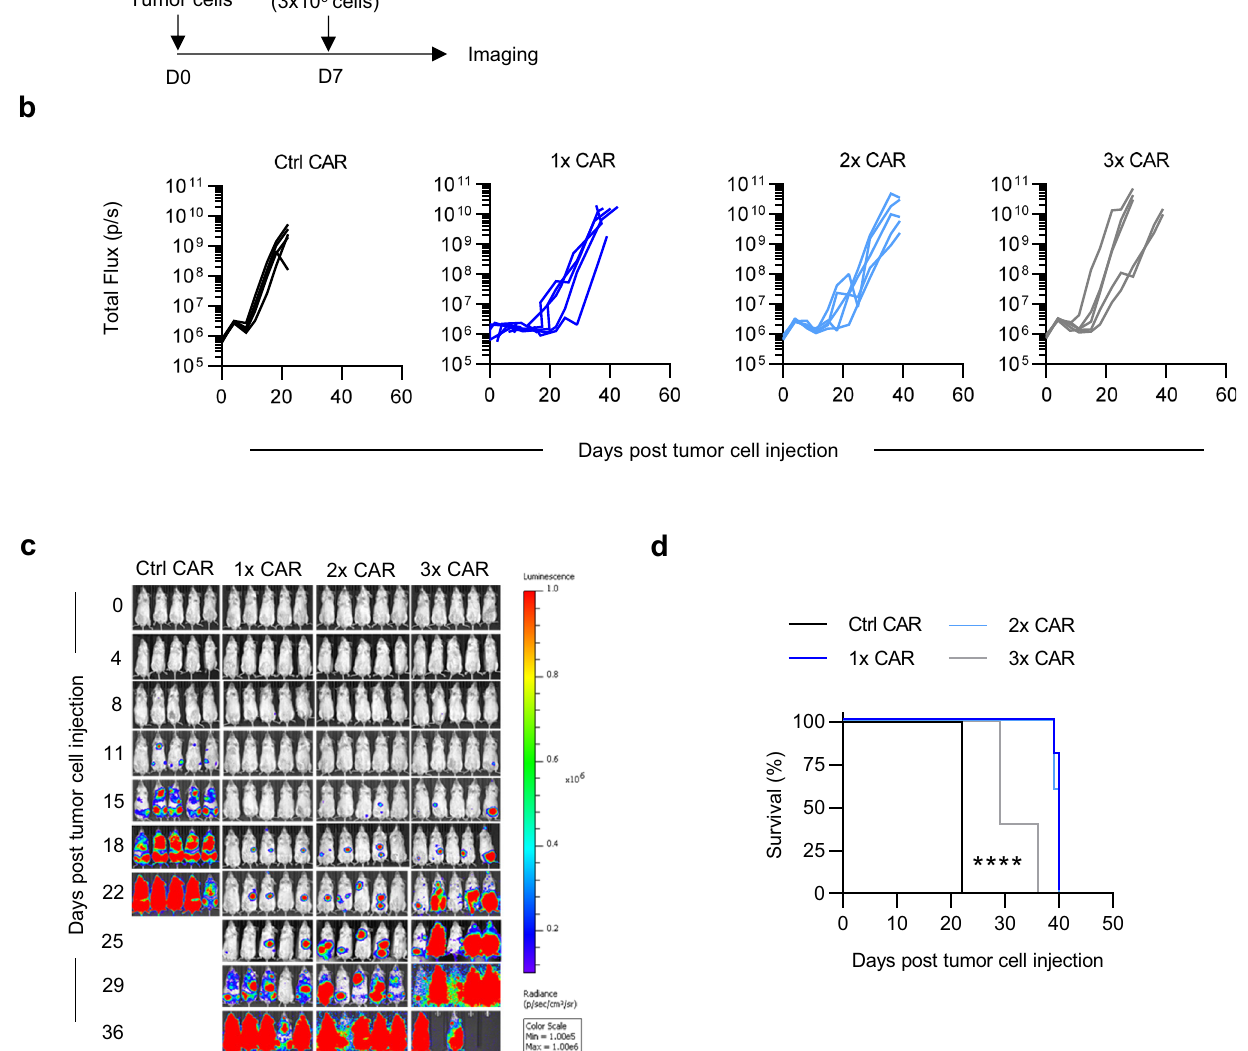
Fig. 5 GRP78-CAR T cells have potent anti-AML activity in vivo. a Schematic of in vivo experimental design. b . MOLM13 xenograft model. NSG mice were injected with MOLM13 (5x10 3 ) cells i.v. (tail vein), and on day 7 received a single i.v. dose of 3 × 10 6 T cells. IVIS imaging was performed twice weekly. c Bioluminescence data (total fl ux = photons/s) d Survival curve ( N = 5, p < 0.005, Log-rank test). Source data are provided as a Source data fi